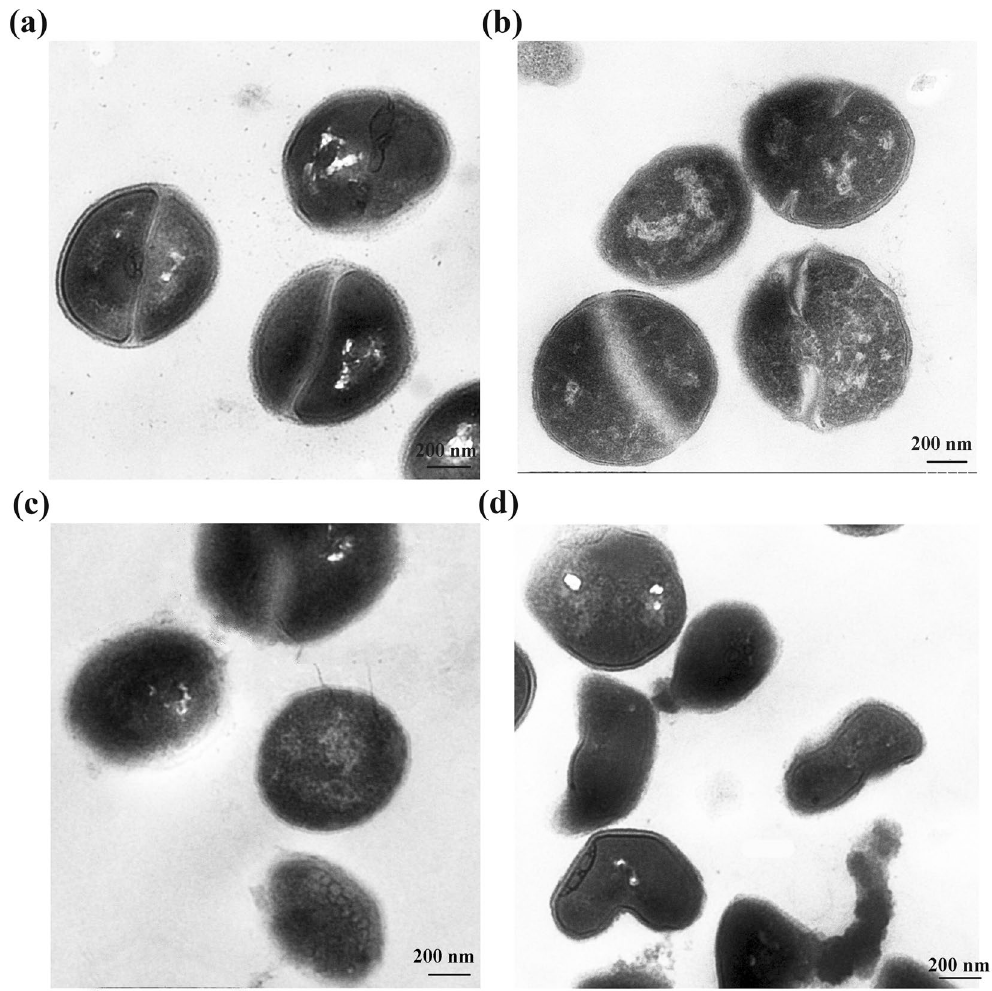
Figure 3. TEM images of untreated S. saprophyticus P2 cells ( a ), as well as cells treated with nisin ( b ), SlpB ( c ), and nisin plus SlpB ( d ). Nisin concentration, 100 μ g/mL; SlpB concentration, 40 μ g/mL.